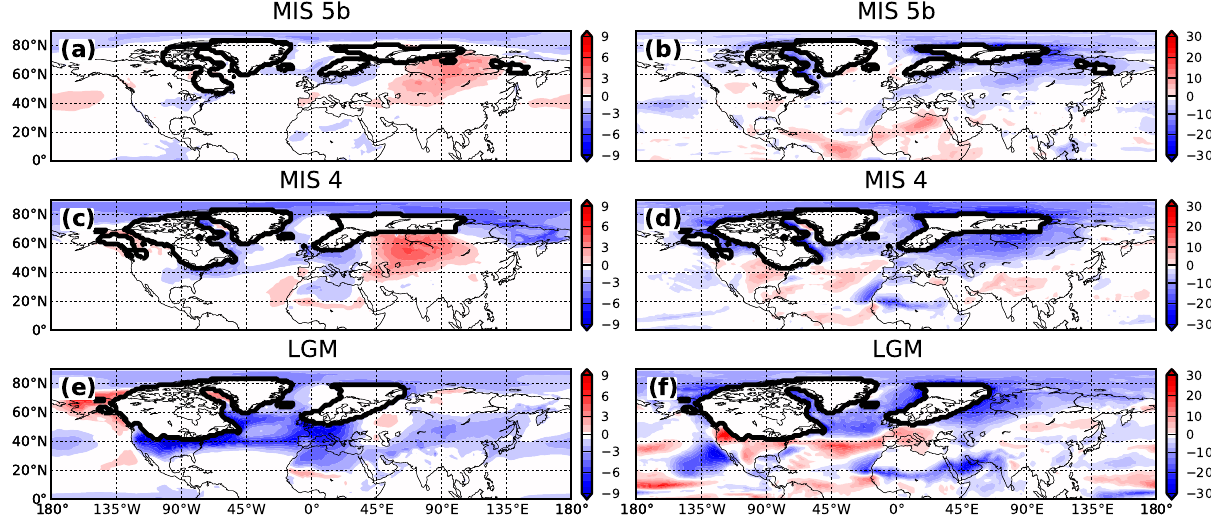
Figure 7. The panels on the left show the difference in average summer (JJA) surface temperature (K) between the full glacial simulations and the no-ice-sheet simulations; see details in the text. The panels on the right show the corresponding difference in the total cloudiness (%). Note that values over the ice sheets are masked out for display